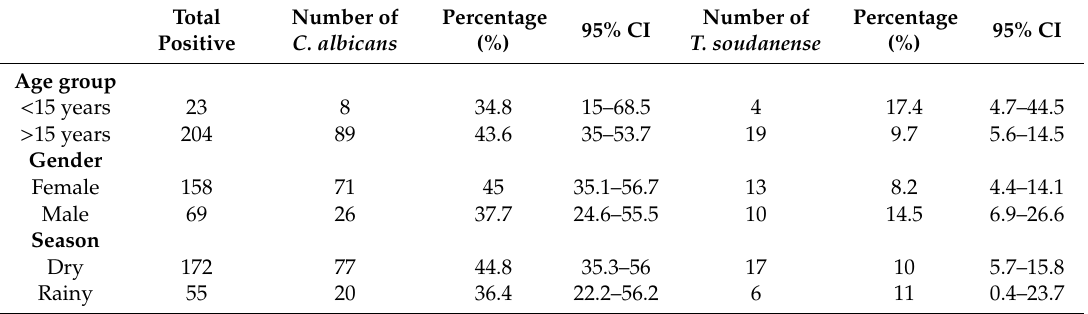
Table 6. Variation of Onychomycosis caused by Candida albicans and Trichophyton soudanense according to the socio-demographic characteristics of